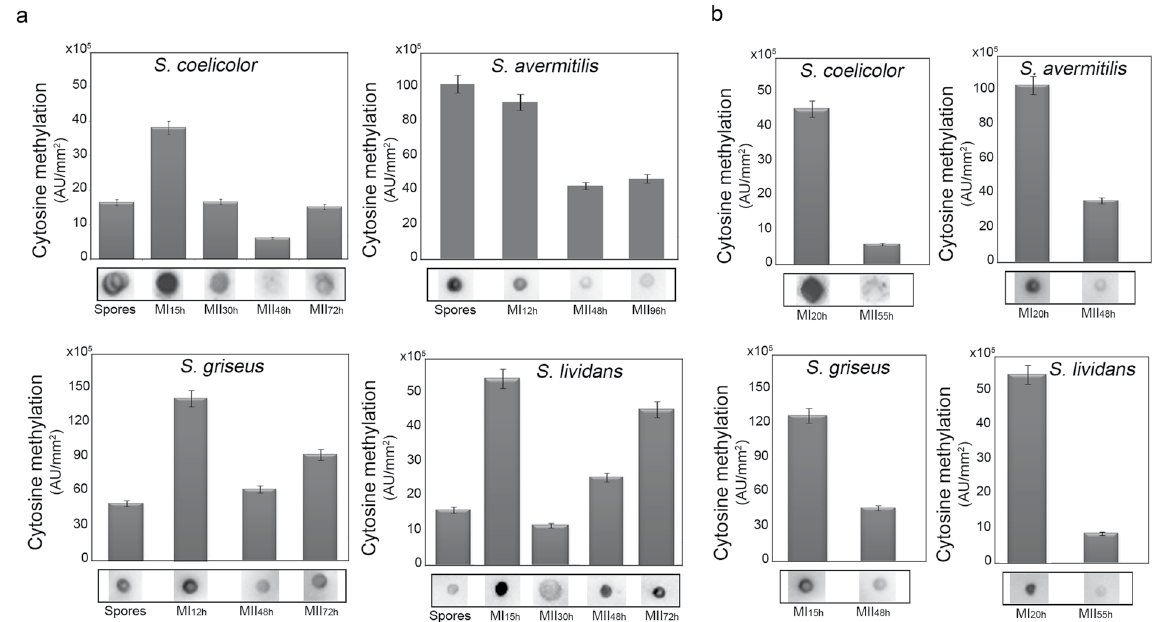
Figure 1. Methylation levels along the different growth phases of S . coelicolor , S . lividans , S . griseus and S . avermitilis . Genomic DNA was extracted from bacterial cultures grown both in liquid and on solid medium and analyzed by dot blot assay with antibody against 5MeC. Bars represent methylation levels in arbitrary units (AU) quantifying dot blot signal intensities. Error bars were obtained from three independent experiments. Examples of dot blots are shown below the bars. MI and MII stages are indicated. ( a ) Solid cultures. ( b ) Liquid cultures. MII 48h and MII 72h correspond to aerial and sporulating aerial hyphae, respectively. The full length blots are included as Supplementary Fig.